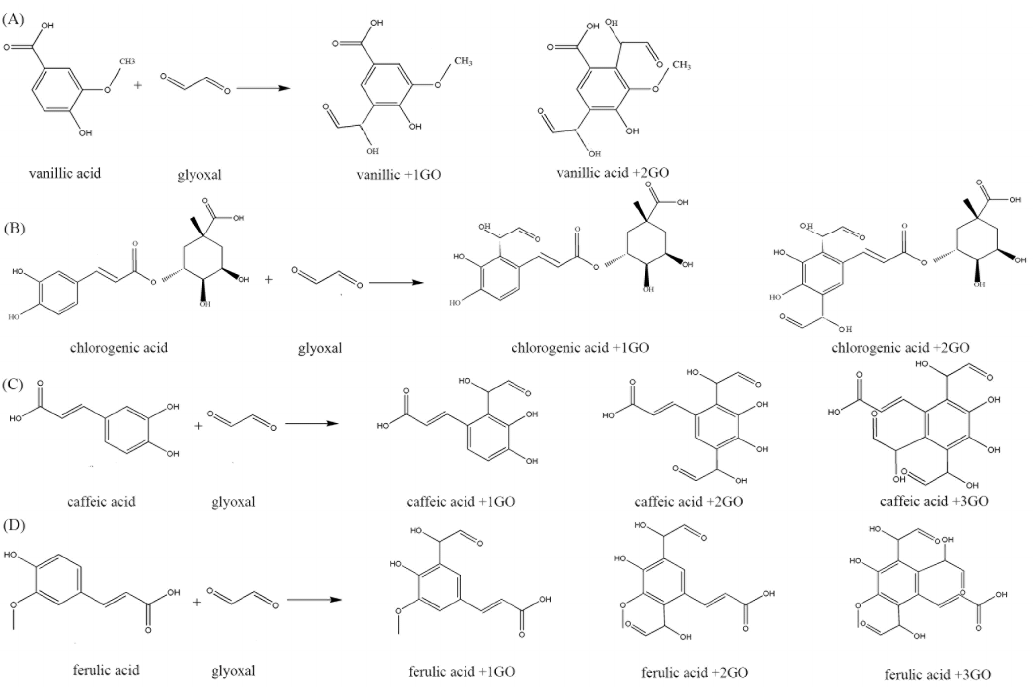
Figure 5. The adduct products of ( A ) vanillic, ( B ) chlorogenic, ( C ) caffeic, and ( D ) ferulic acids following reaction with GO.